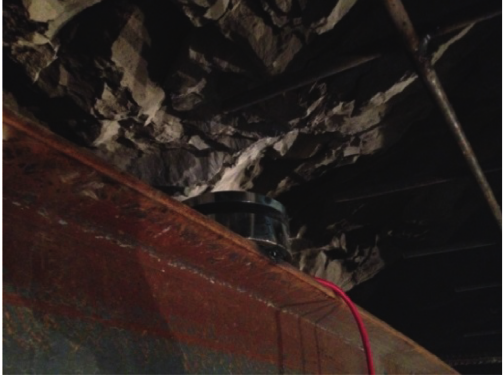
Figure 35: Installation diagram of soil pressure sensors.